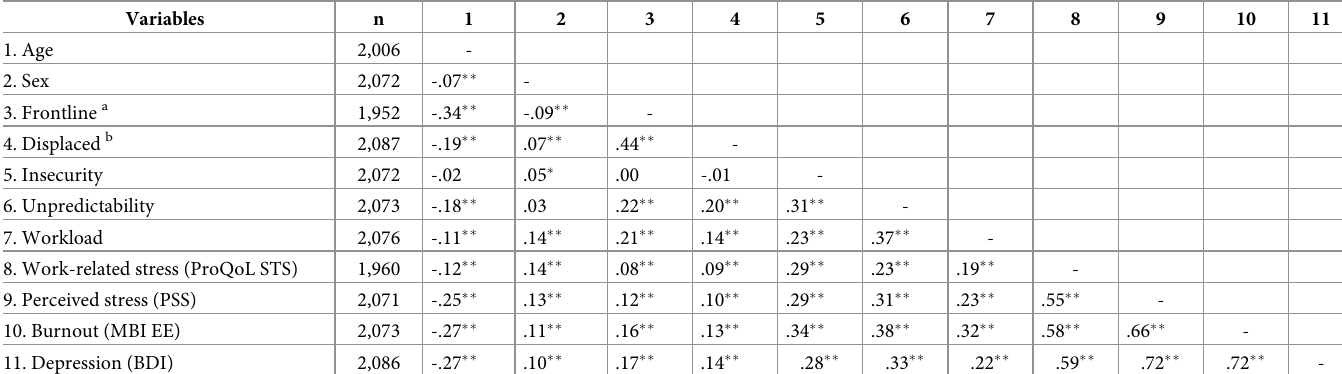
Table 2. Pearson correlations for study variables.